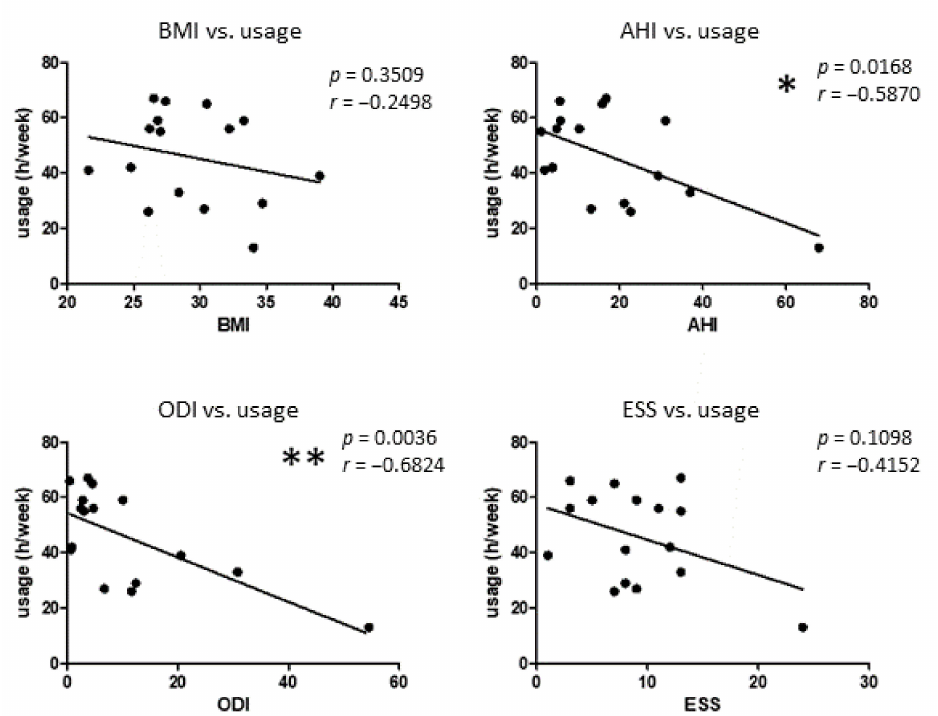
Figure 2. Correlation analysis between HNS usage time (h/week) and BMI (body mass index), AHI (apnea–hypopnea index), ODI (oxygen desaturation index), and Epworth Sleepiness Scale (ESS) before and after HNS therapy, respectively. A multivariate progression with the Pearson correlation was performed. The correlation coefficient (r) and p -values are shown for each correlation. *: p < 0.05; **: p <